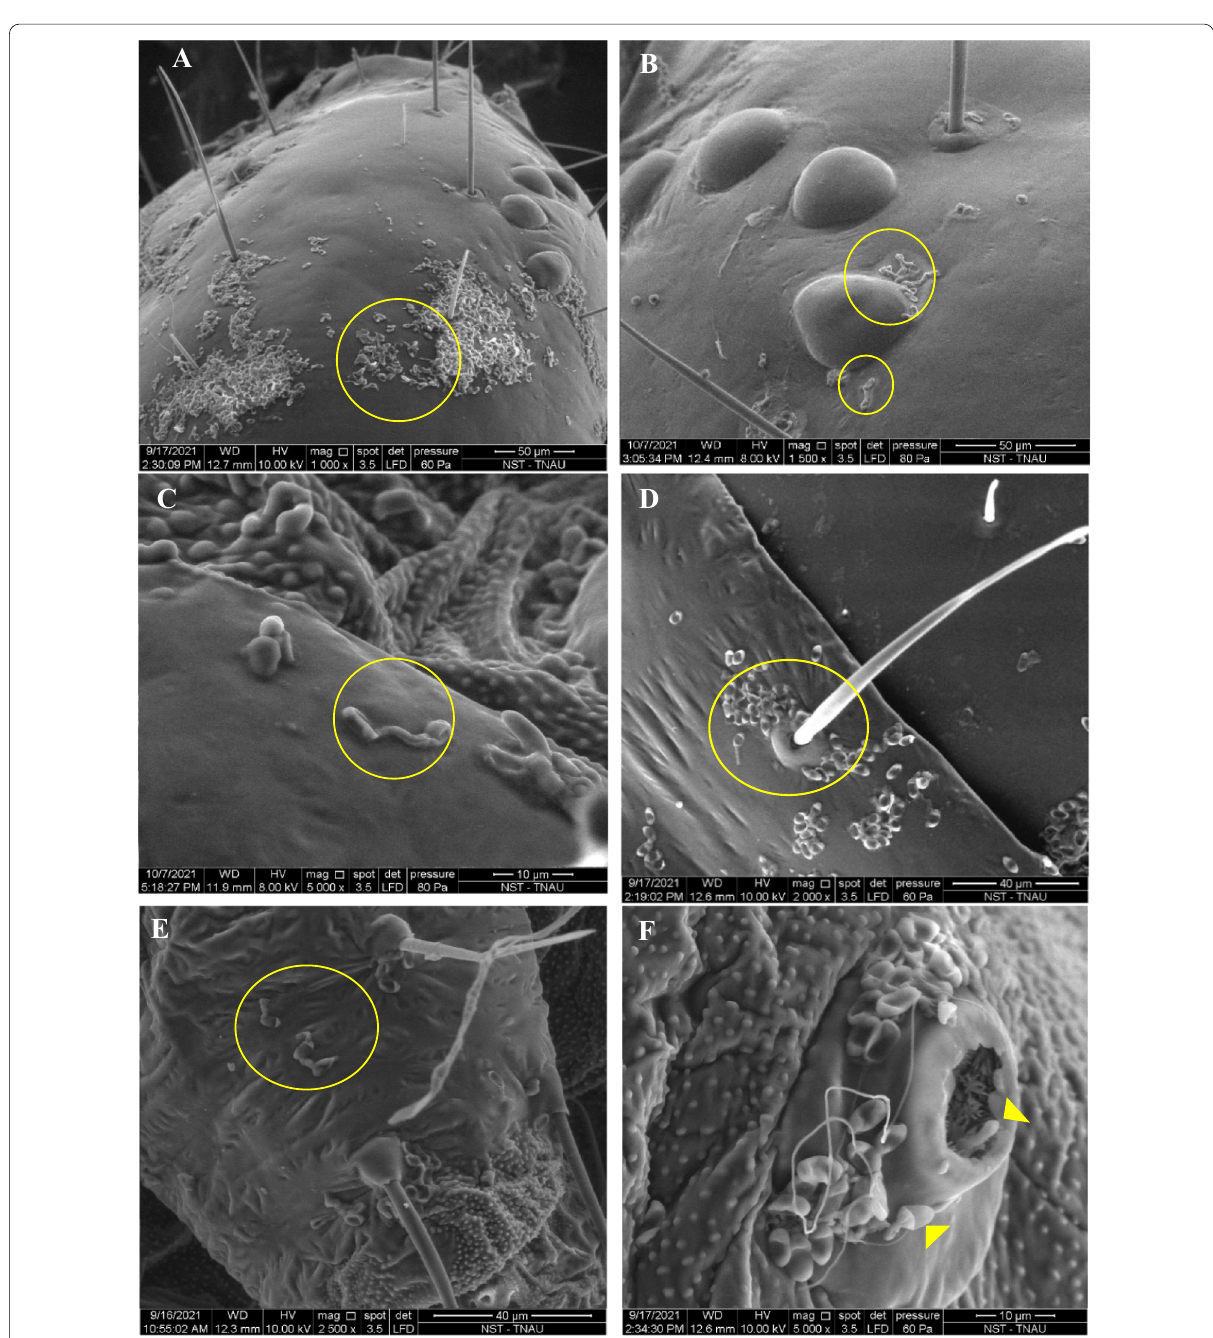
Fig. 4 SEM images of second instar of Spodoptera frugiperda infected with Metarhizium anisopliae (48 hpi). a . Head region showing germinating conidial clusters (circle). b . Close-up of germinating conidia with germ tube around stemmata (arrowhead). c . Conidia with germination tube in thoracic region (circle). d . Conidial germination near the base of setae (circle). e . Base of prolegs having conidia with germ tube and appressoria (circle). f . Conidial germlings of M. anisopliae with germtube around spiracular region